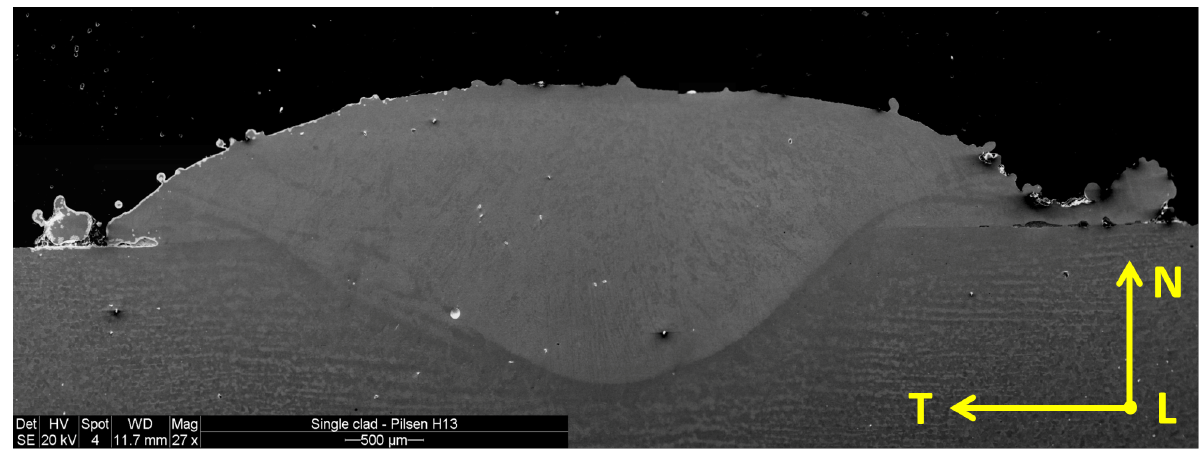
Figure 1. SEM image of the cross-section of the single clad AISI H13 tool steel with marked